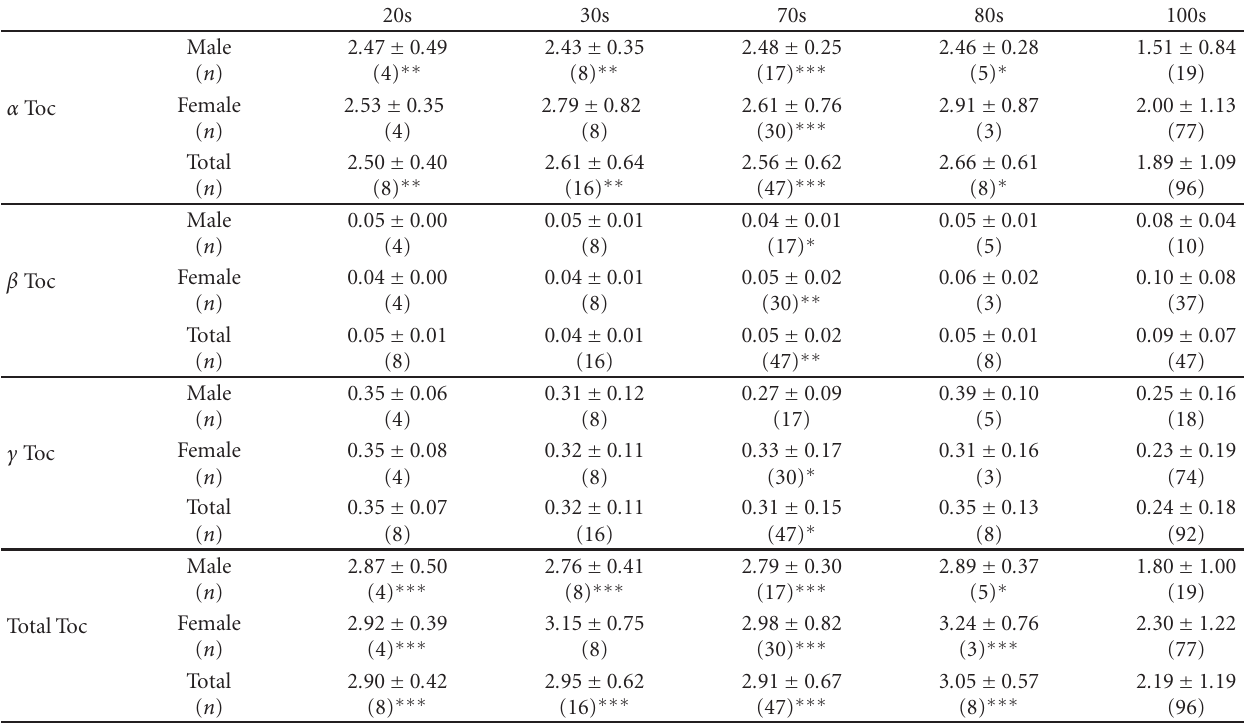
Table 3: Mean intracellular (red blood cell) tocopherol levels by age strata (total and subtype) ( μ g/ml).